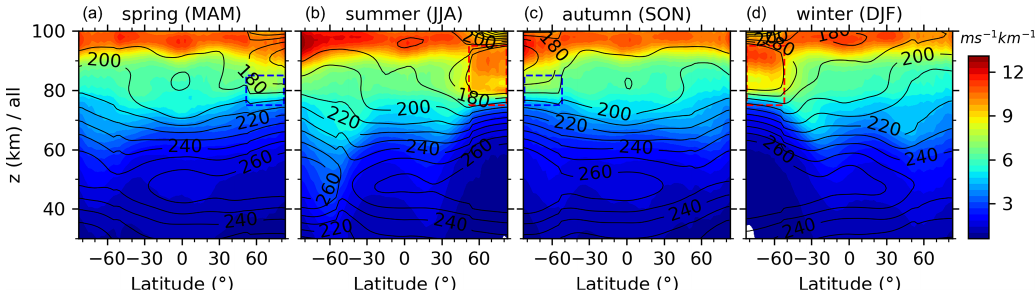
Figure 14. Same as Fig. 6 but for the zonal means of GW-perturbed shears derived under the medium-frequency assumption f/ ˆ ω j = 0.